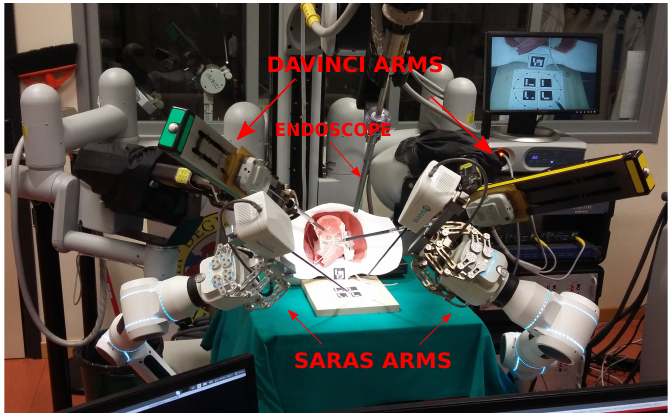
Figure 11. The setup used for the experiments. SARAS, Smart Autonomous Robotic Assistant Surgeon.